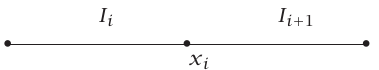
Figure 2.2 . An illustration for the jump